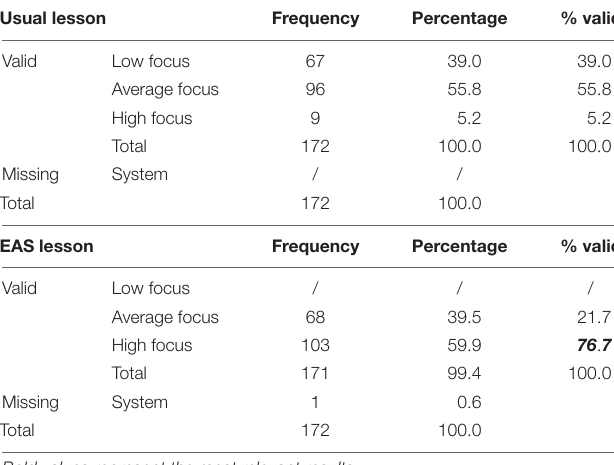
TABLE 9 | Differences in attention and active work between usual lessons and EAS lessons.